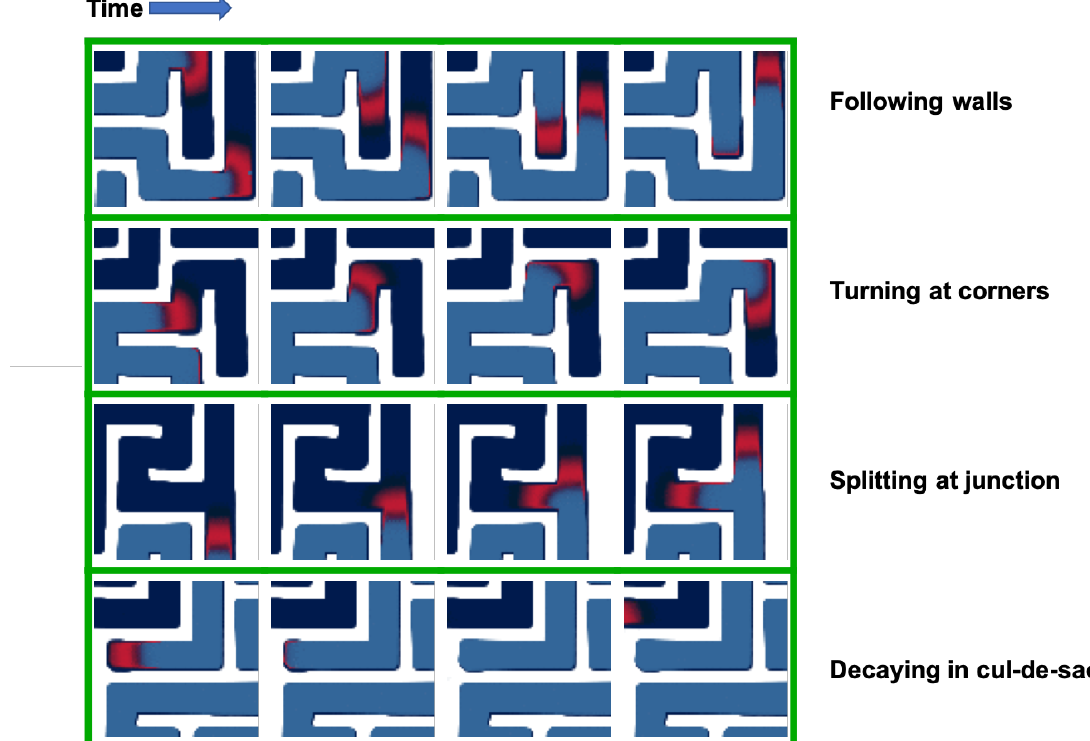
Figure 2. Effect of boundary conditions on the dynamic of the system. The predator-prey system generates traveling waves of preys (in red) followed by a front of predators (blue). The traveling waves closely interact with the geometry of the reactor. They follow straight walls, turn at corners, split at junction, and go extinct in cul-de-sacs. For each geometrical effect, four representative snapshots are presented (taken at an interval of 2000